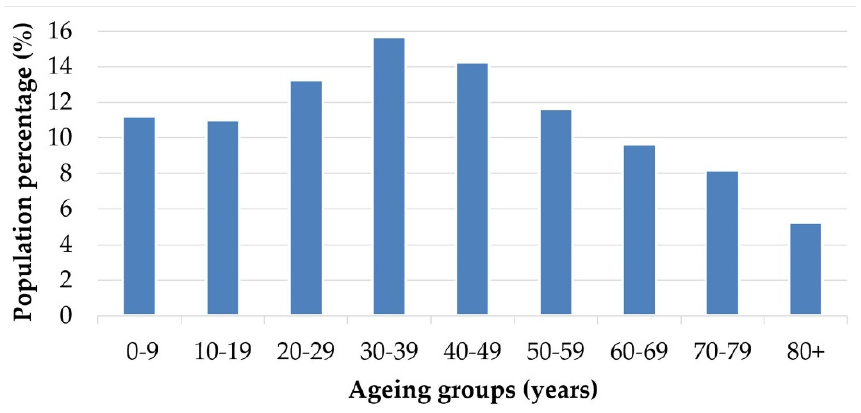
Figure 2. Location of Crete in relation to Greece (adapted from https://www.touropia.com/regions- of-greece-map/, accessed on 6 March 2022).